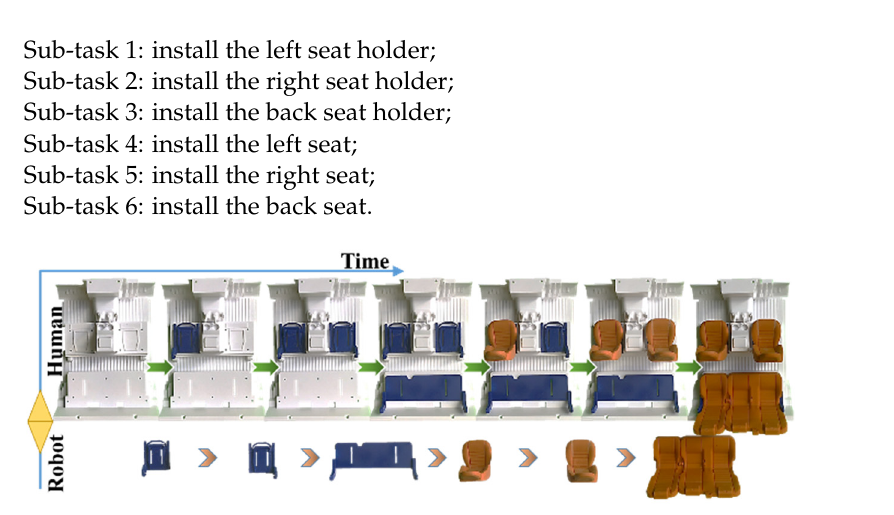
Figure 4. The vehicle seat assembly task in the